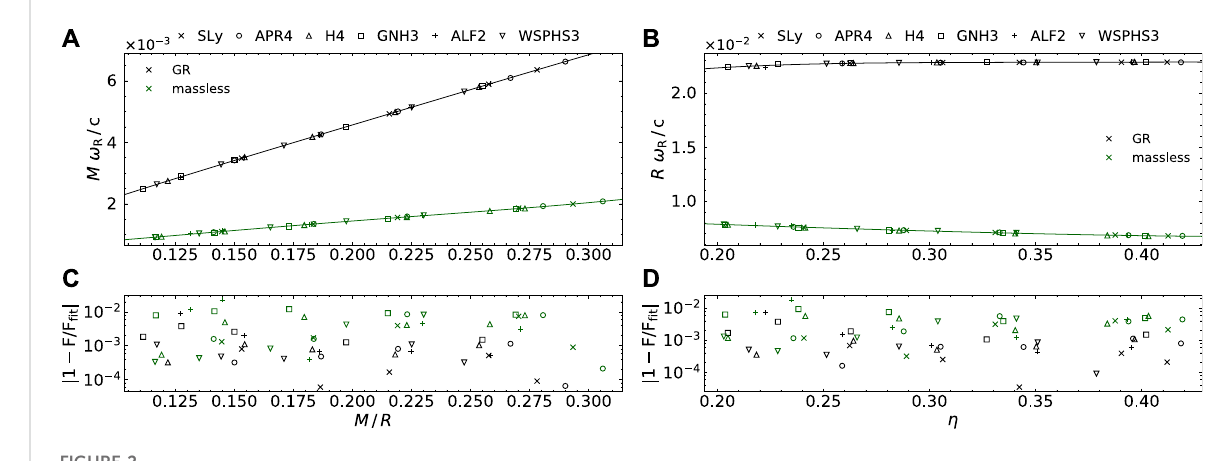
FIGURE 2 Quadrupole ϕ -mode universal relations: dimensionless frequency M ω R / c versus compactness C = M / R (A) and fi t errors (C) ; dimensionless frequency R ω R / c versus generalized compactness η (B) and fi t errors (D) . The symbols indicate the respective equation of state. The massless scalar – tensor case is shown in green, and the general relativistic case is shown in